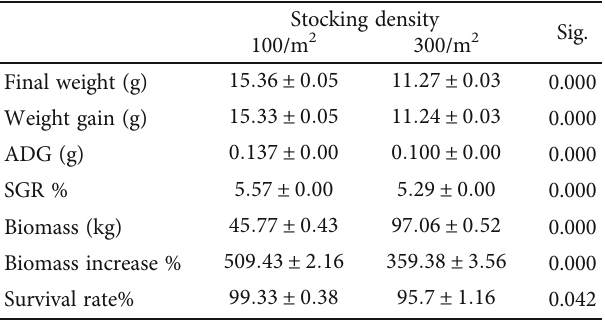
Table 3: Growth performance parameters and survival rate of whiteleg shrimp L. vannamei reared under di ff erent density bio fl oc systems for 135 days.